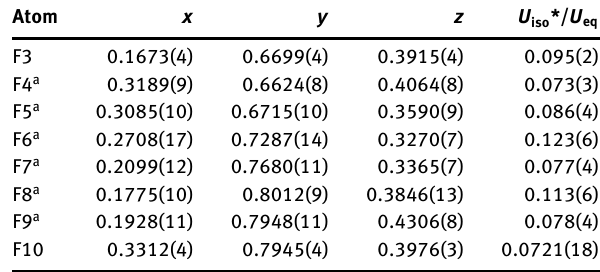
Table 2: Fractional atomic coordinates and isotropic or equivalent isotropic displacement parameters (Å 2